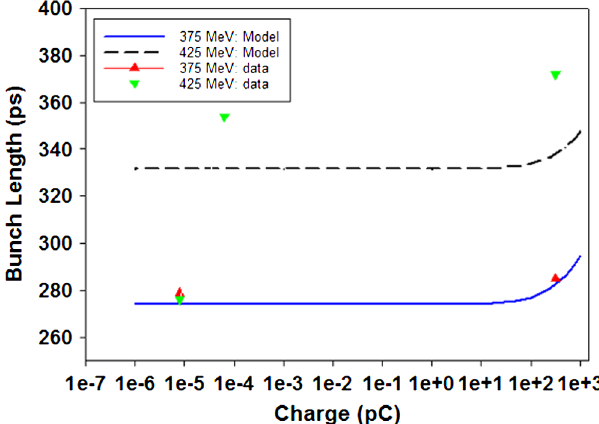
FIG. 11. Predicted equilibrium bunch lengths using the PAR impedance model for a range of charges and the two energies, 375 and 425 MeV [25]. Measured values are also shown as